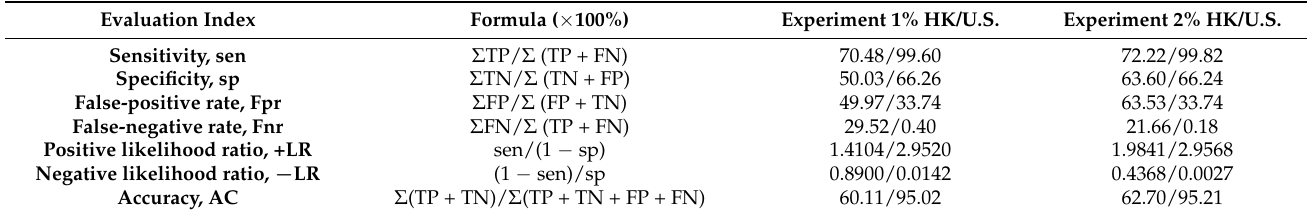
Table 10. Evaluation Results of Screening Plan for